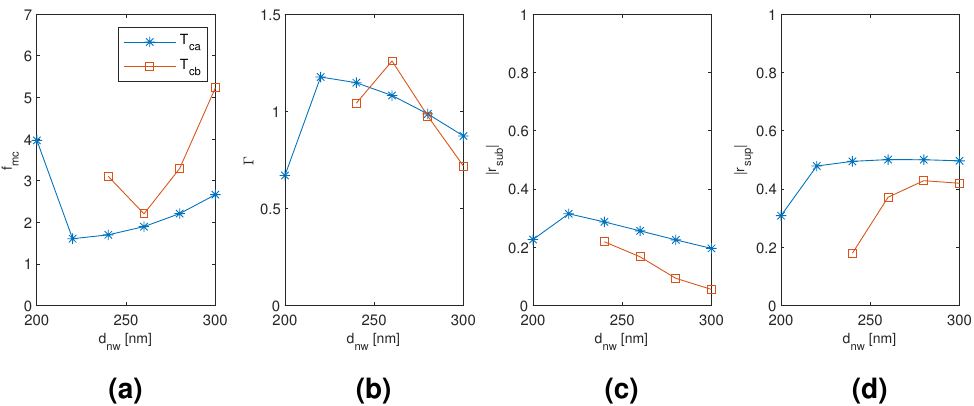
Figure 15. The results for the coated tetramer T ca and T cb mode as a function of the diameter of the nanowires with the coating thickness and the separation of the nanowires corresponding to the point of modal cost function minimum for each mode (as listed in Table 2). ( a ) modal cost function value; ( b ) modal confinement factor; ( c ) substrate modal reflection coefficient magnitude; ( d ) superstrate modal reflection coefficient